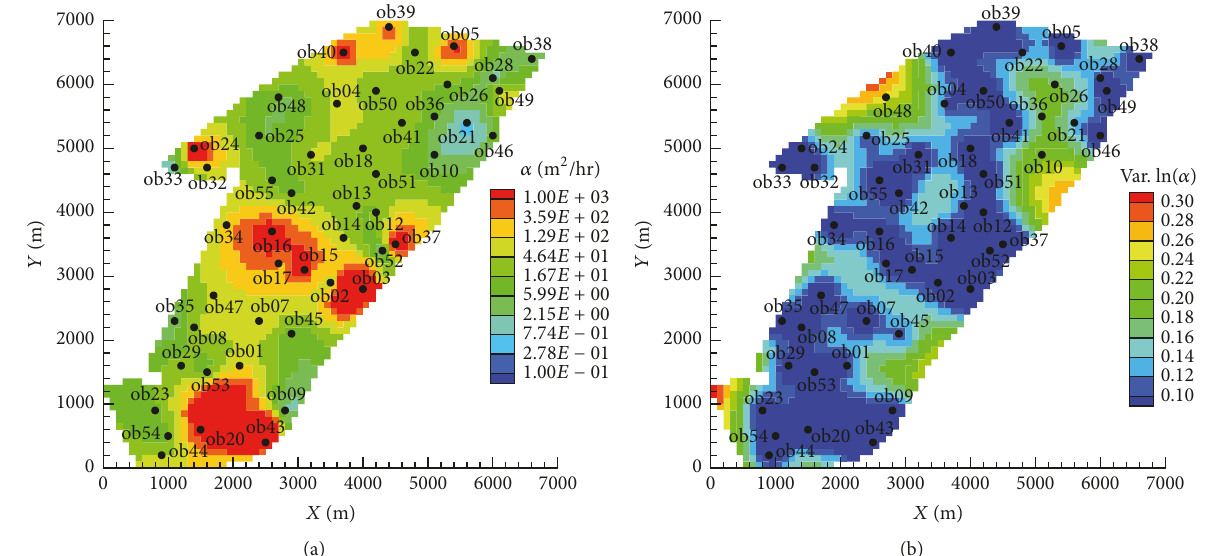
Figure 12: Optimal estimated heterogeneous 𝛼 field in the real aquifer (50th observation well used for the inverse model). (a) Optimal estimated heterogeneous 𝛼 field; (b) uncertainty of 𝛼